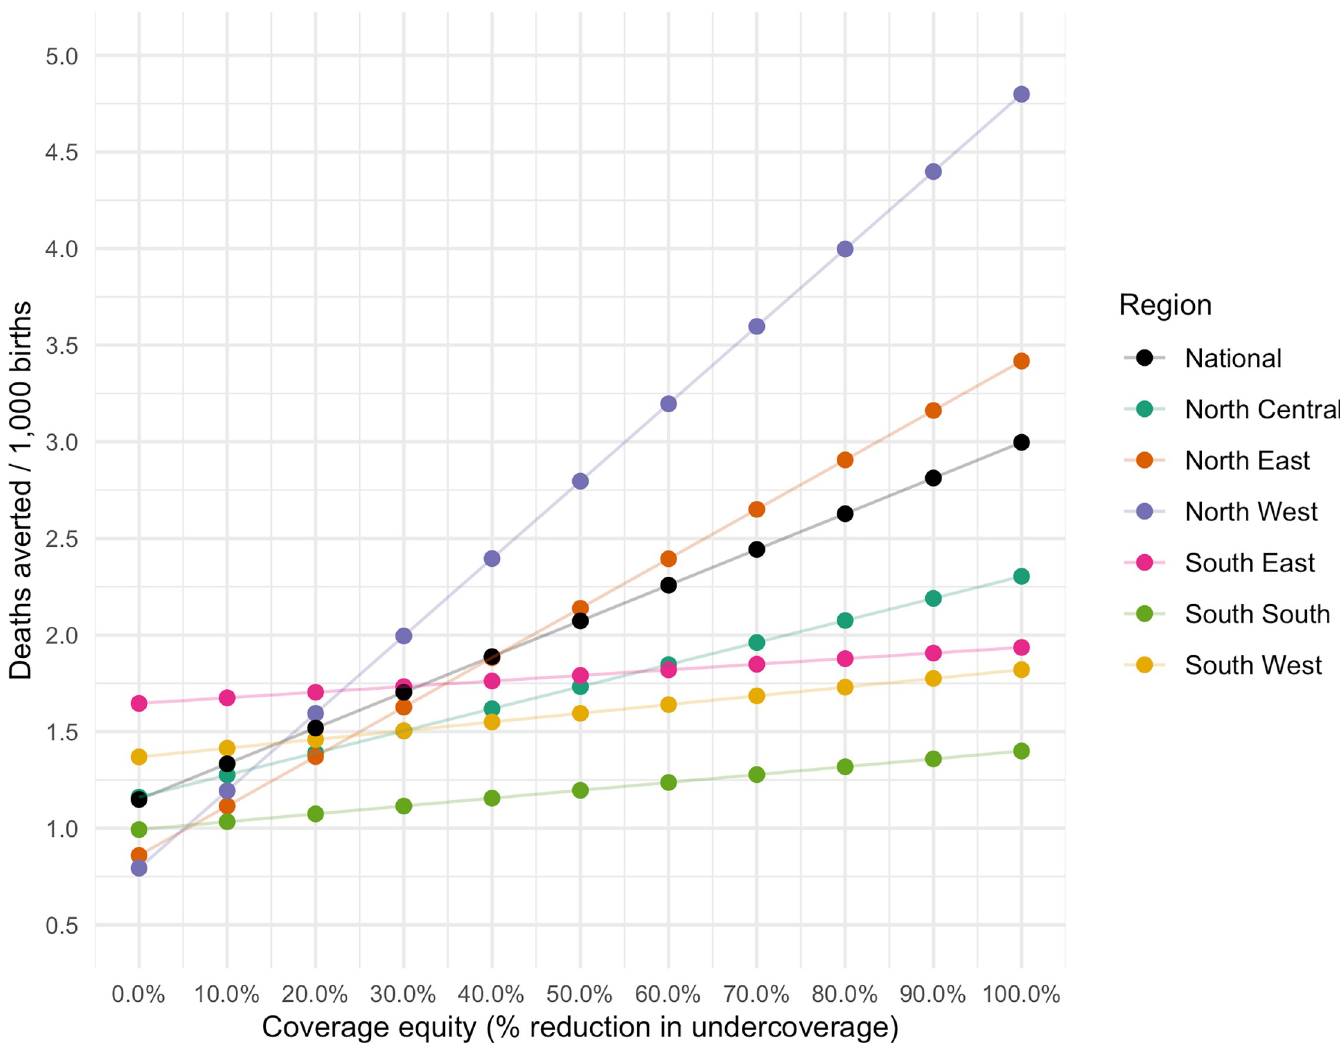
Fig 5. Results of a scenario where the benefits (deaths averted per 1,000 births) are estimated in response to incremental 10% reductions in the percentages of unvaccinated children (undercoverage) in each